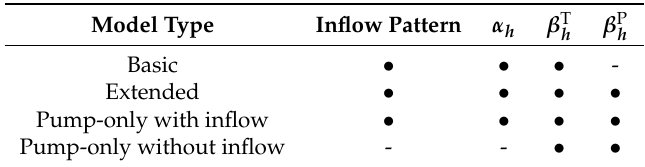
Table 1. Model types and active criteria when clustering equivalent hydro models (active criteria indicated by •